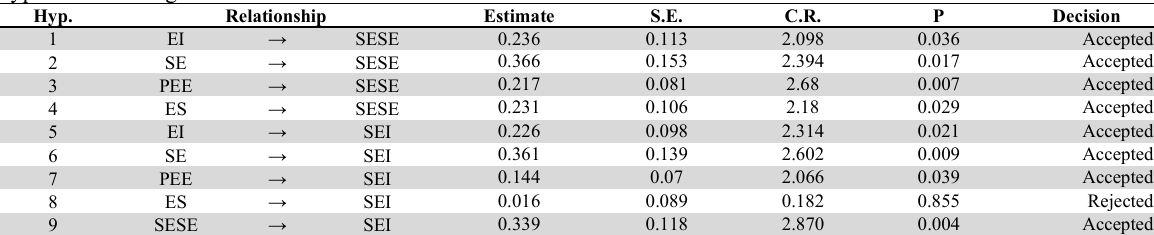
Hypothesis Testing Result